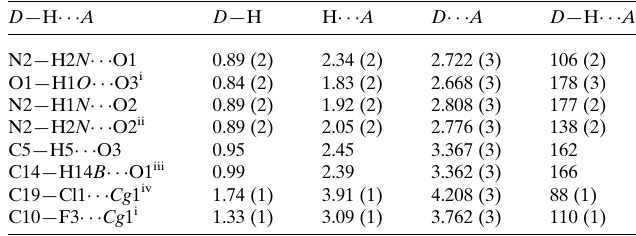
Table 1 Hydrogen-bond geometry (A˚ , (cid:4)